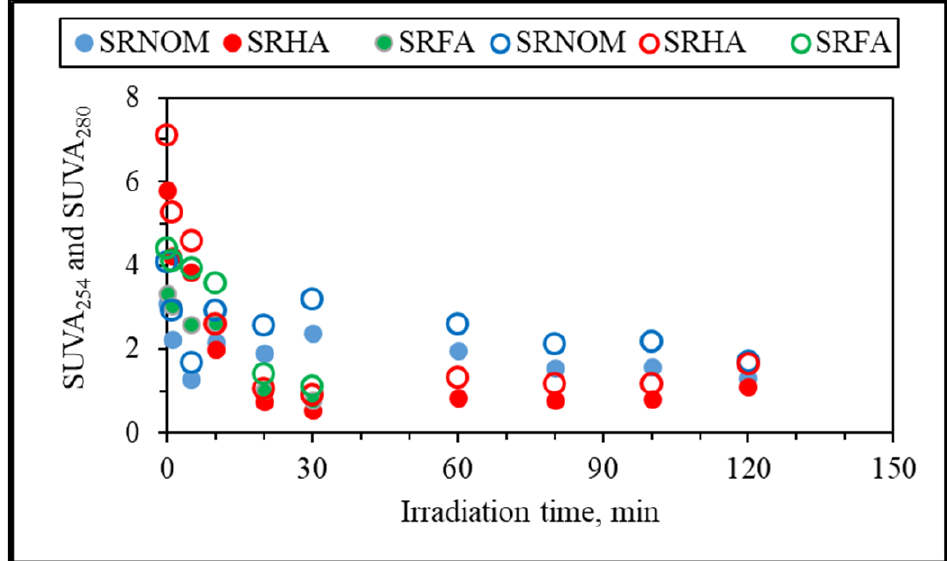
Figure 6. Specific UV parameters of the organic matrix released from E. coli inactivation in the presence of NOM analogue compounds. Closed circles represent SUVA 280 , and open circles represent SUVA 254 .